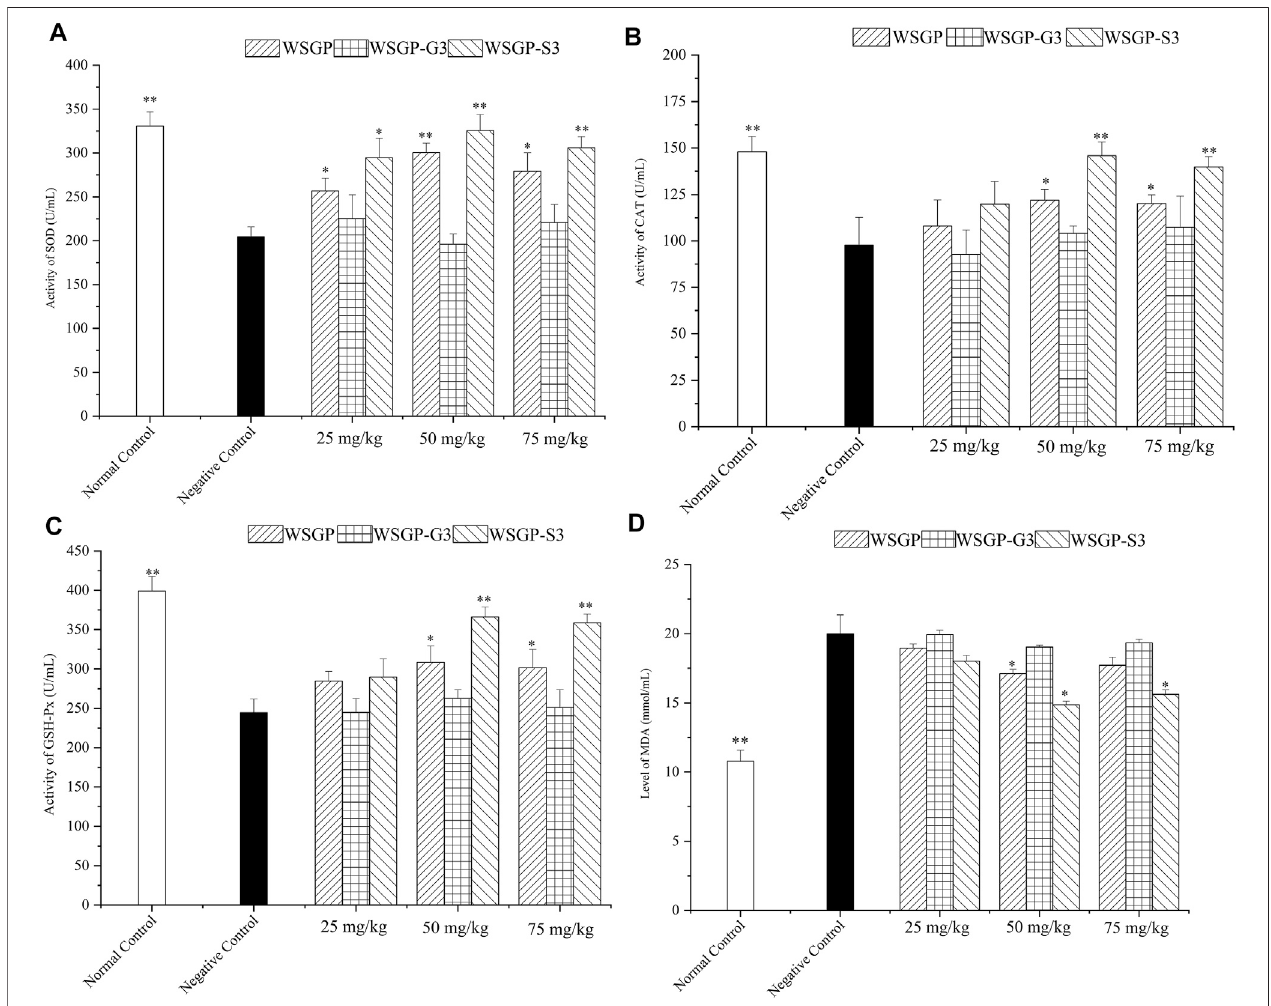
FIGURE 5 | Effects of the polysaccharides on the antioxidant system of fatigued mice. (A) Activity of SOD; (B) Activity of CAT; (C) Activity of GSH-Px; (D) Level of MDA. * p < 0.05, ** p < 0.01 vs. the negative control group.